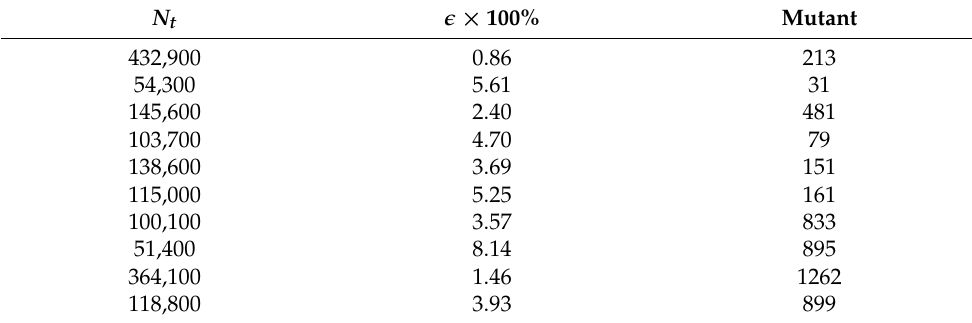
Table 5. Fictitious data set B ( w =